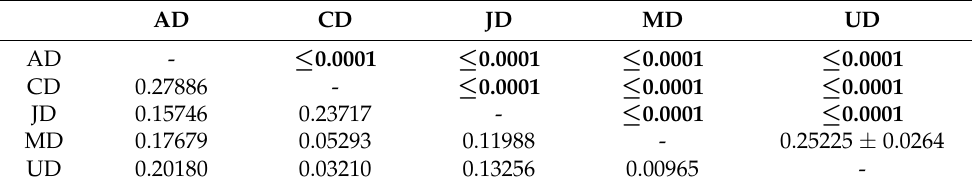
Table 2. FST values estimated from 15 loci studied in the four groups of T. truncatus .